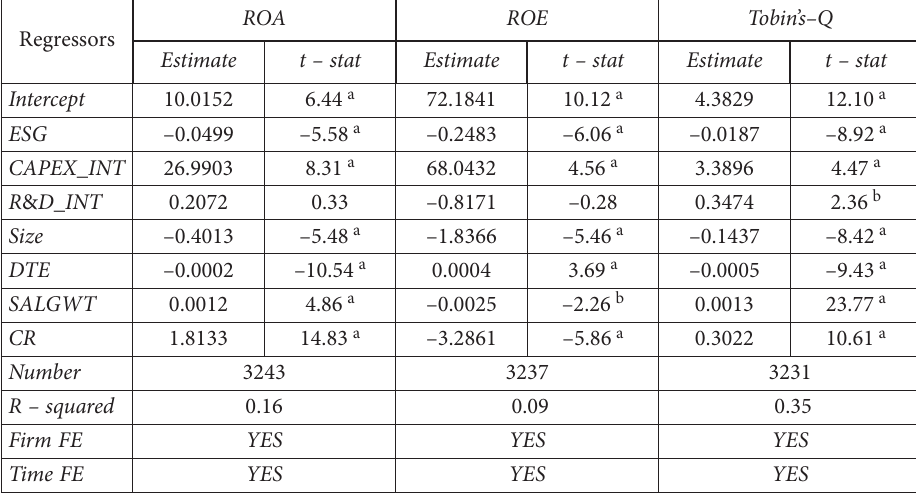
Note : Table shows the regression output for the Eq. (1), showing the link between ESG practice and firms’ financial performance. Robust standard errors for the test’s statistics. Significant at a 1%, b 5%, c 10%